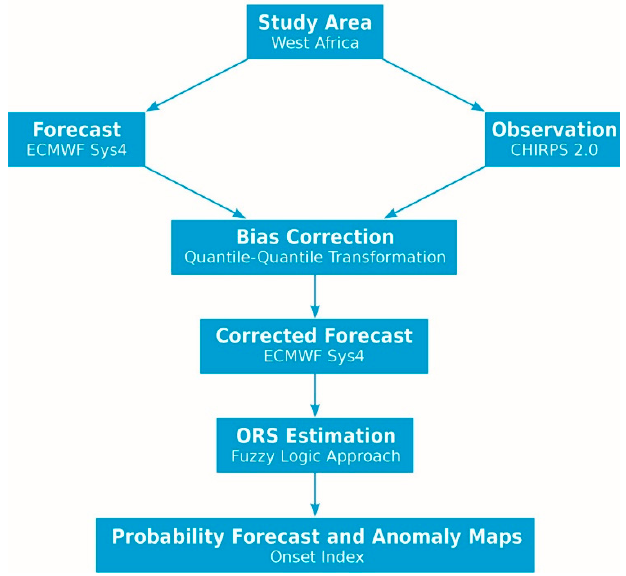
Figure 2. Schematic overview of the different components of the forecasting procedure for the onset of the rainy season (ORS) proposed in this study. CHIRPS 2.0 = Climate Hazards Group Infrared Precipitation with Station data version 2, and ECMWF SYS4 = seasonal forecast system SYS4 of the European Centre of Medium Range Weather Forecasts.